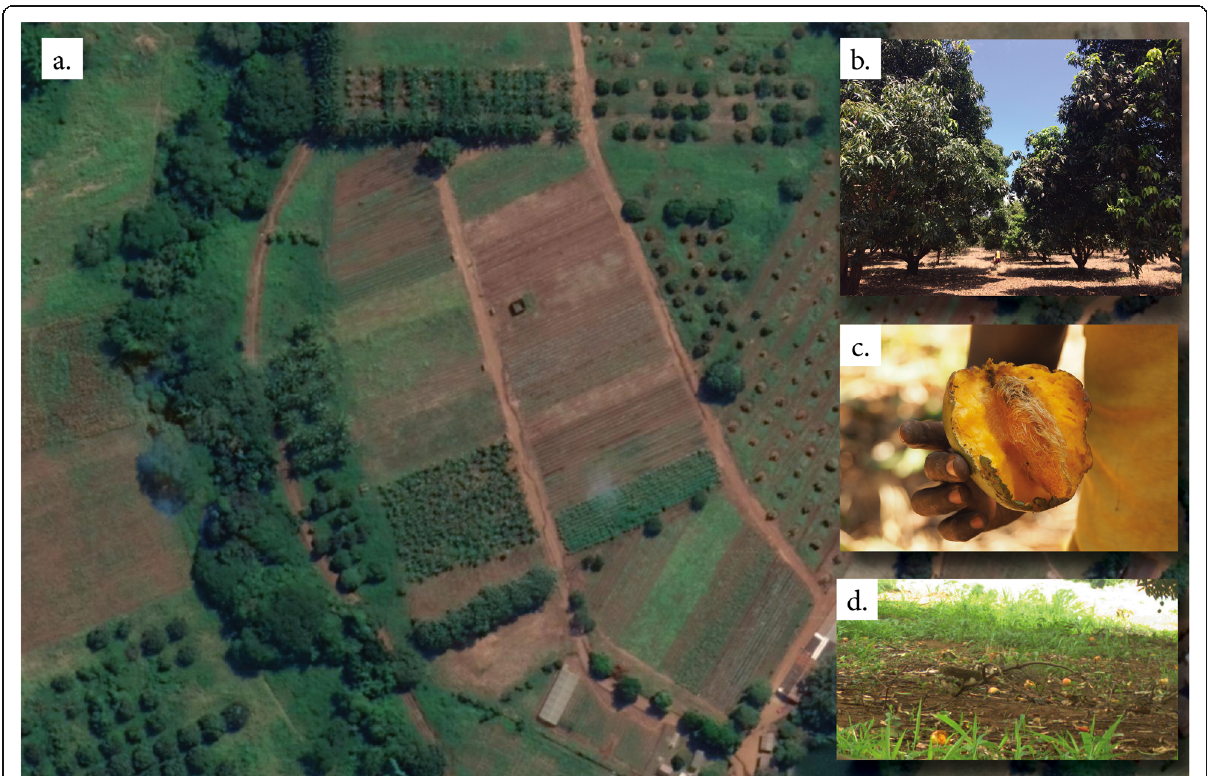
Fig. 6 a. Site for setting up camera-traps, identified by tracking data. b. Worker harvesting mangoes at this site. c. Half-eaten mango discarded by foraging bats. d. Discarded mangoes on the ground under mango